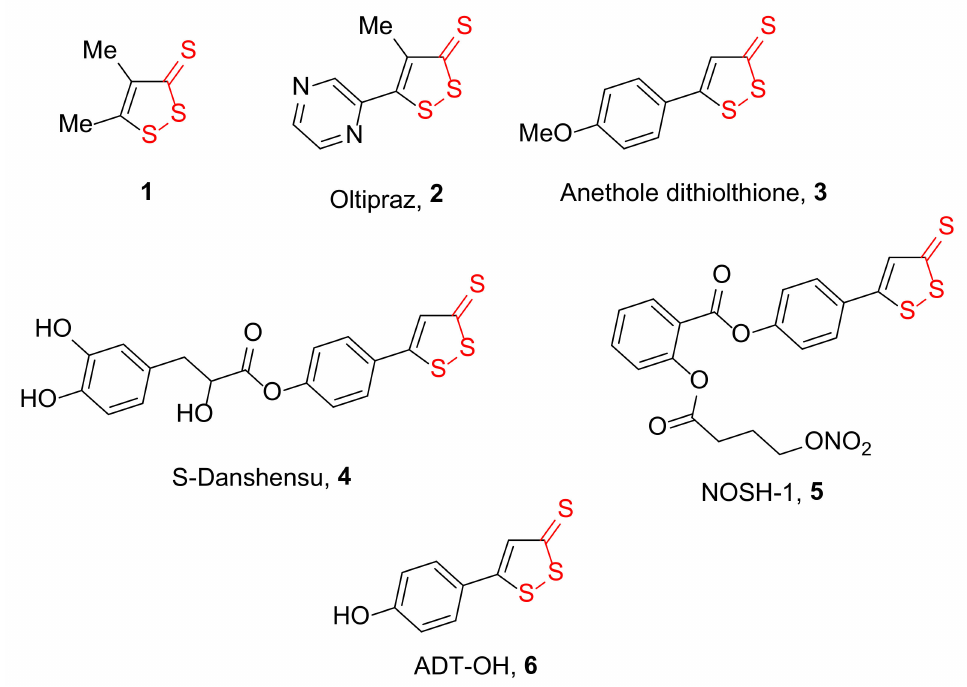
Figure 1. 4,5-Dimethyl-1,2-dithiole-3-thione ( 1 ) and 1,2-dithiole-3-thione-containing drugs ( 2 – 6